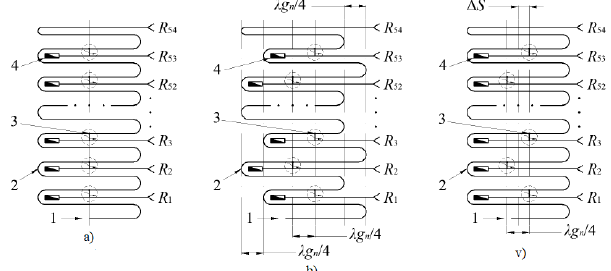
FIGURE 10. Variants of the location of periodic inhomogeneities in the power divider: a) there is no shift between even and odd periodic inhomogeneities; b) even and odd periodic inhomogeneities are spaced relative to each other by λg n /4; v) even and odd directional couplers are spaced relative to each other by λg n /4, there is no shift between the even and odd bends of the delay line; 1 - input of the antenna array; 2 - sinusoidal delay lines; 3 - directional coupler; 4 - balanced load directional